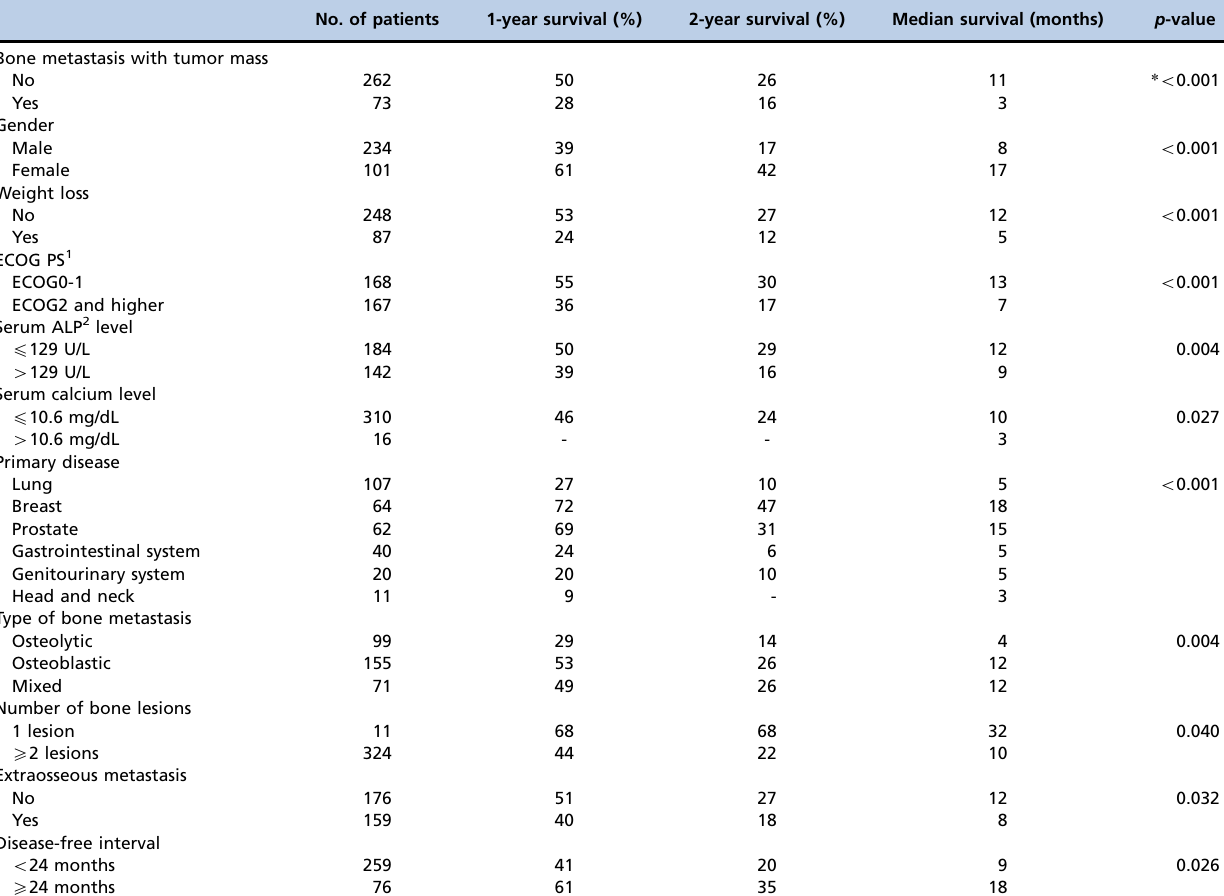
Table 2 - Prognostic factors affecting patient survival after the development of bone metastasis, as determined by univariate survival analysis. No. of